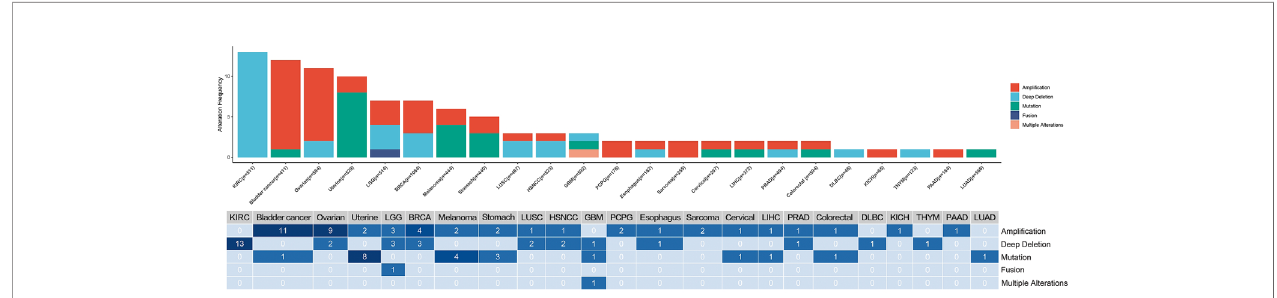
FIGURE 2 | The frequency of CMTM6 copy number alterations and mutations in multiple